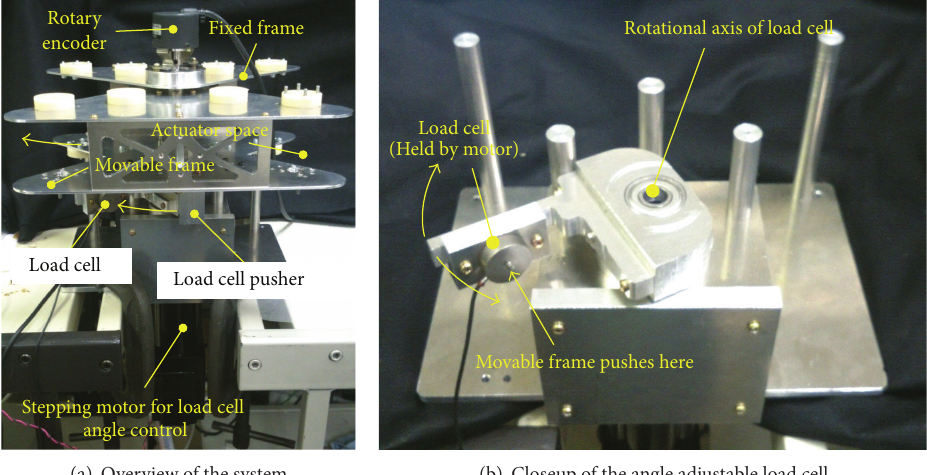
Figure 9: Torque and power measurement system for the prototype joint.